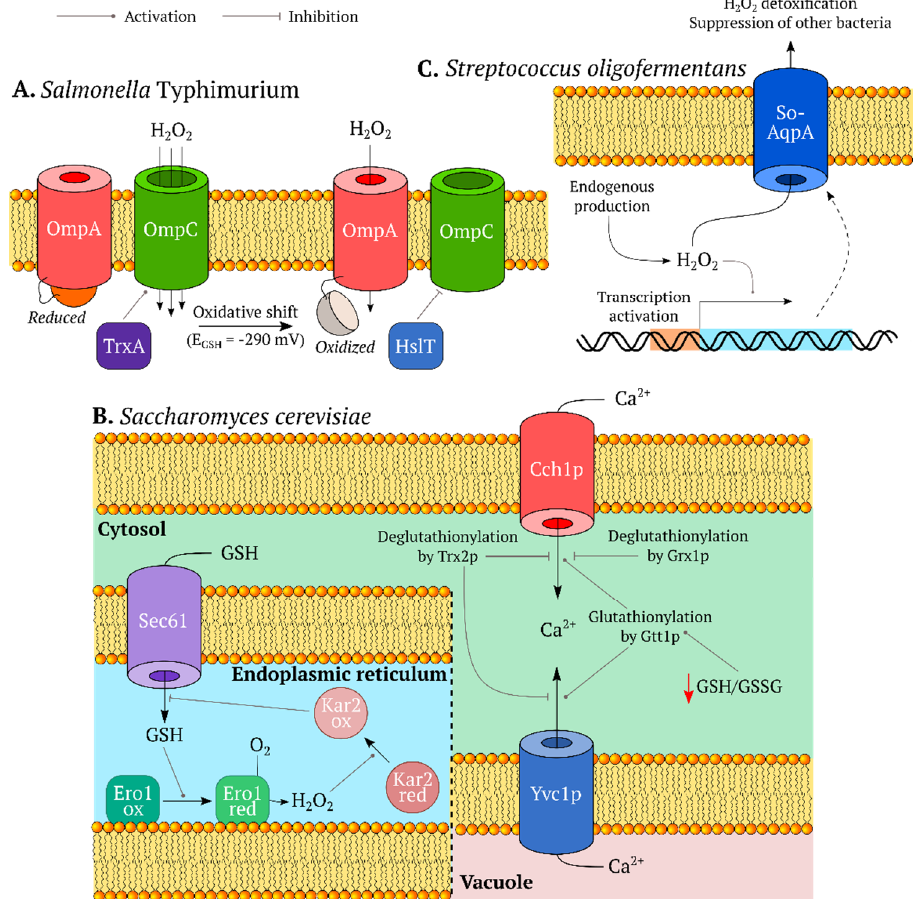
Figure 7. Many membrane transport systems are regulated in a redox-dependent manner. ( A ) In Salmonella , an oxidative shift in the E GSH value leads to a rapid decline in membrane permeability due to redox-dependent closure and opening of OmpC and OmpA proteins, respectively [258]. ( B ) Blue